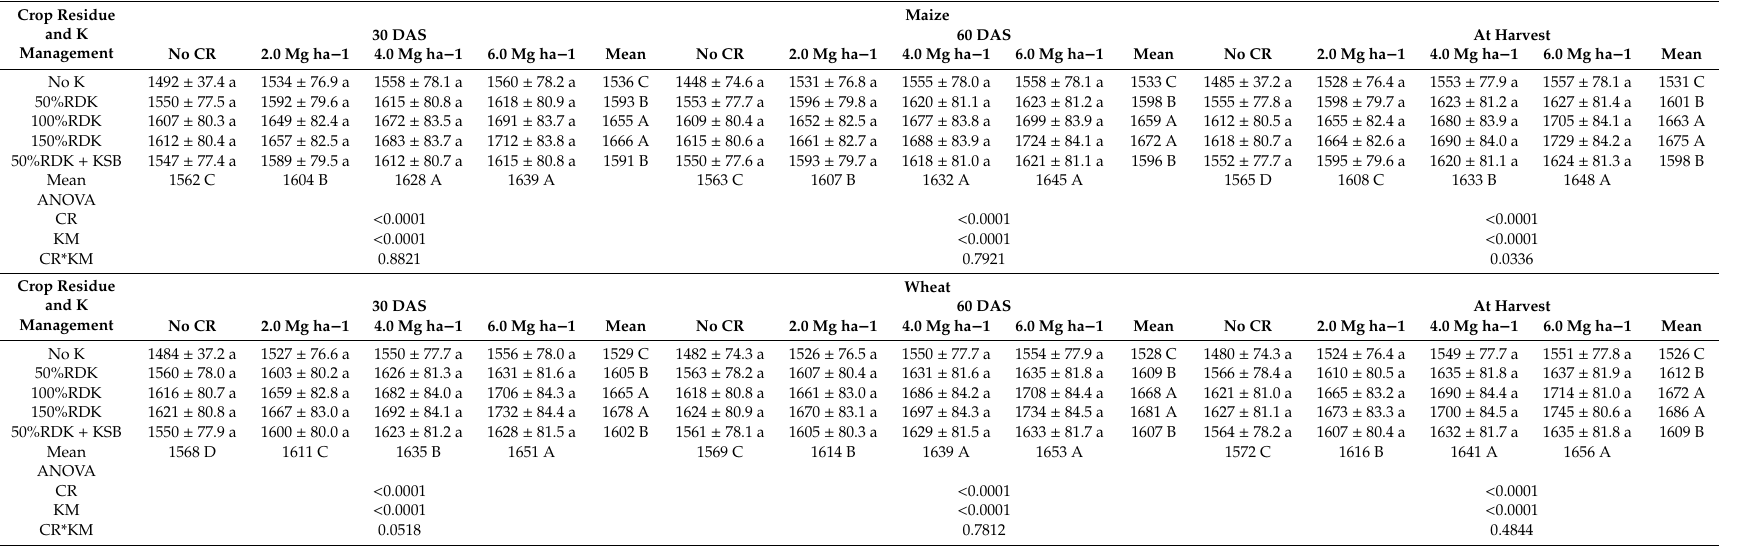
Data are means of three replicates ± Standard deviation; means with di ff erent small and capital letters in the same column and rows di ff er significantly at p = 0.05 according to Fisher LSD and turkey’s test. CR: Crop residue, KM: Potassium management, RDK: Recommended dose of potassium, KSB: Potassium solubilizing bacteria. Values under ANOVA are probabilities ( p -values) of source of